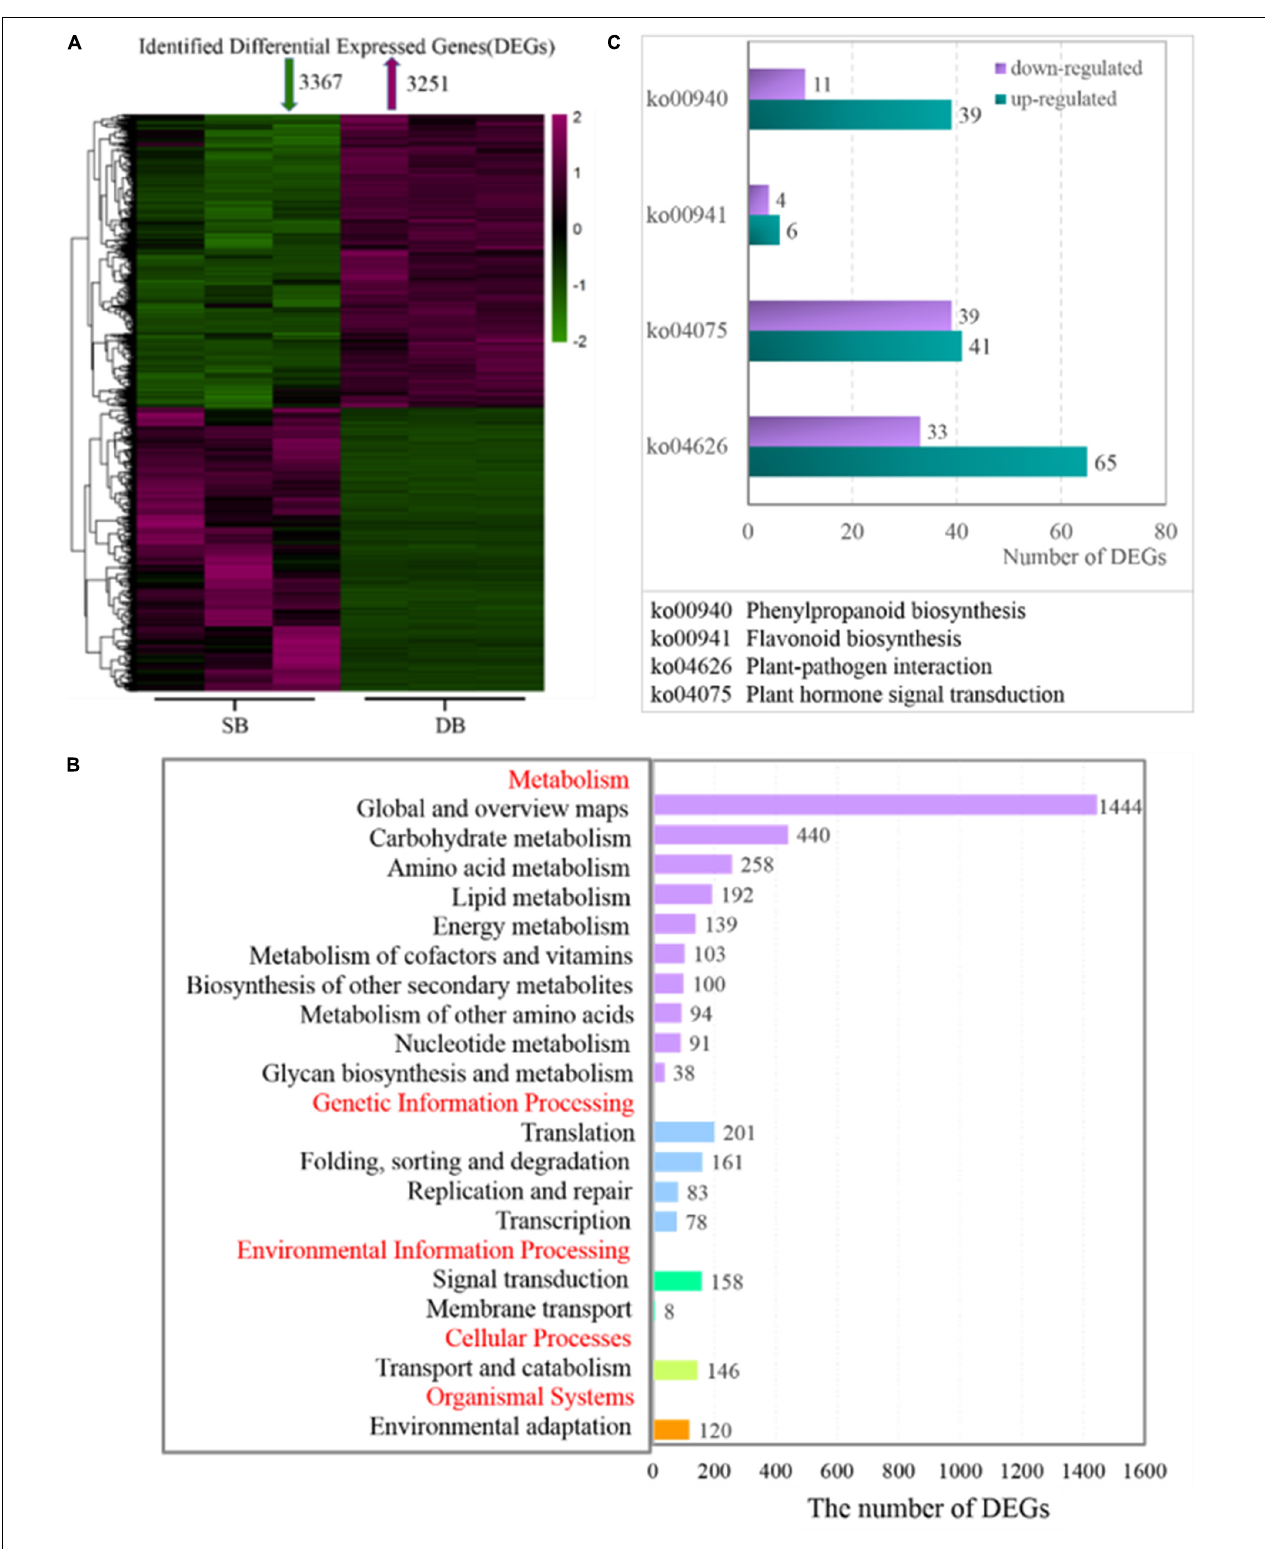
FIGURE 5 | (A) Heatmap of identified differentially expressed genes (DEGs) in the SB and DB tissues. (B) KEGG pathway enrichment analysis. (C) DEG expression in some metabolic pathways. Detailed annotation information of DEGs related to phenylpropanoid biosynthesis, flavonoid biosynthesis, plant-pathogen interaction, and plant hormone signal transduction was shown in Supplementary Table 4